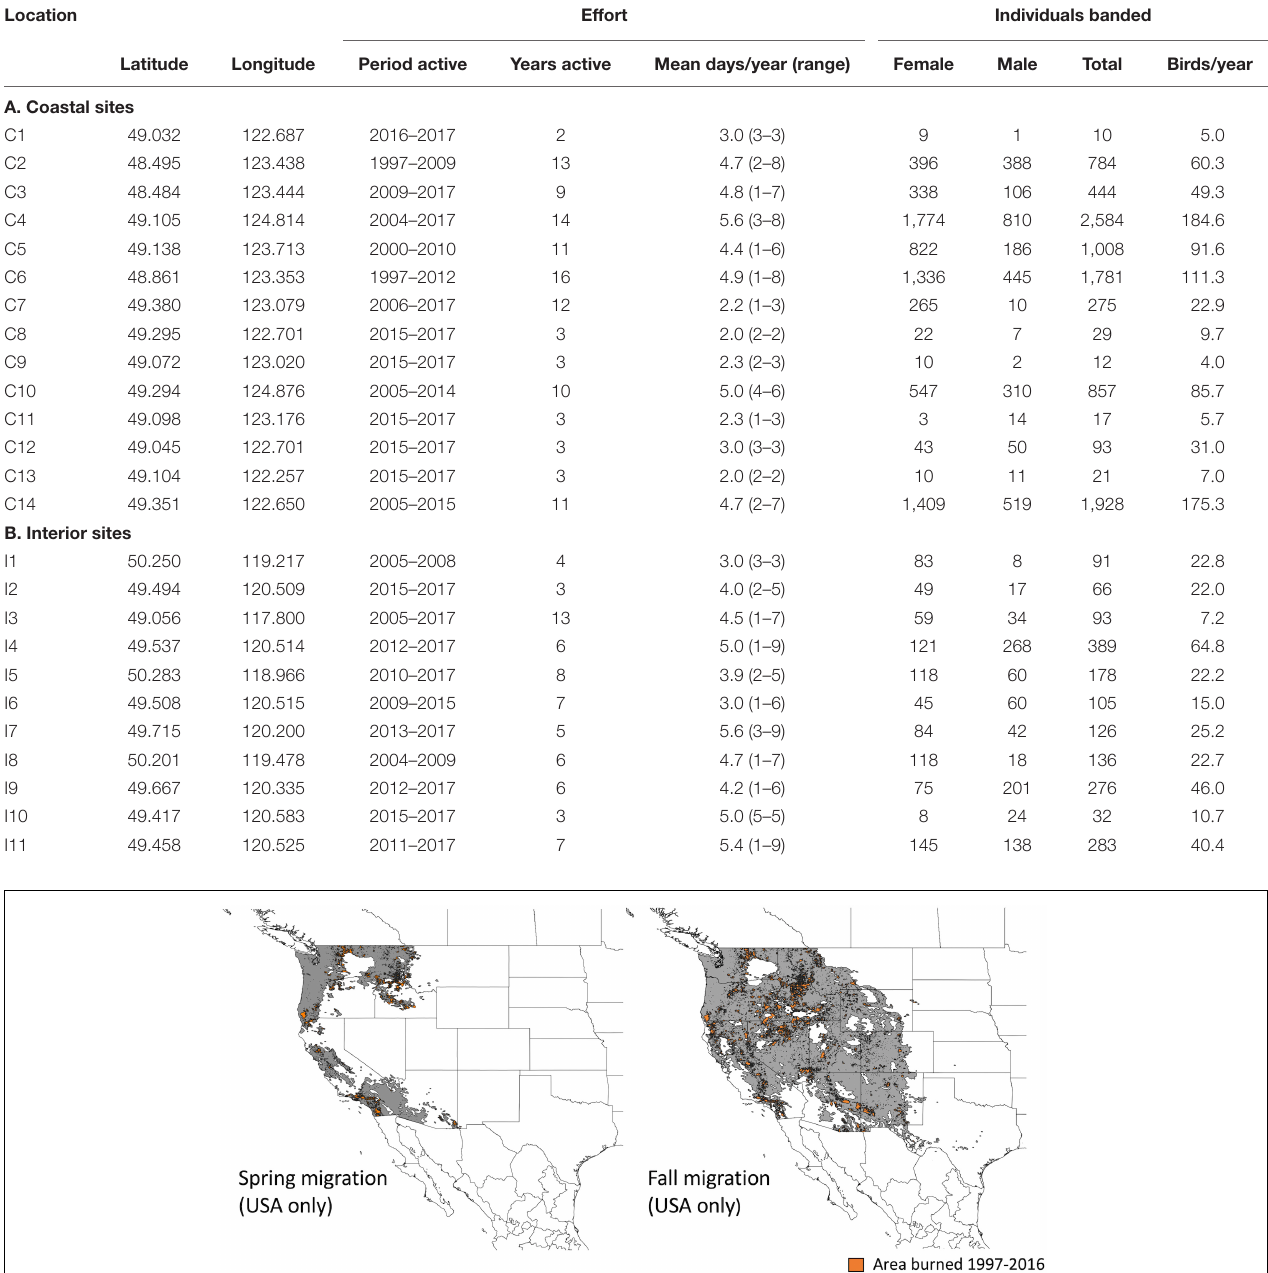
TABLE 2 | Banding station locations, effort, and captures.